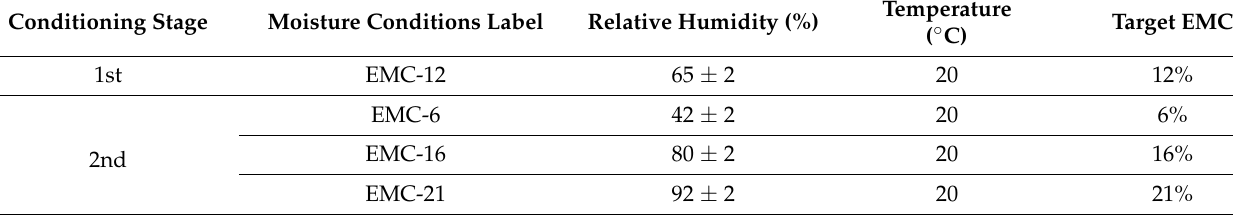
Table 4. Relative humidity and temperature for conditioning and the corresponding equilibrium moisture content (EMC).